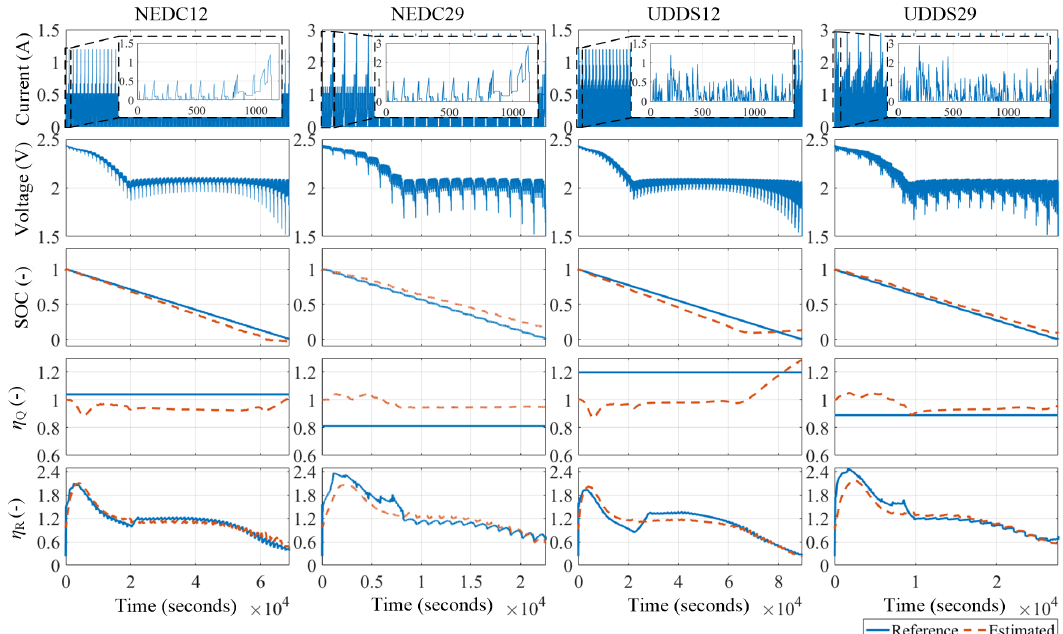
Figure 6. The driving cycle mission profiles and the estimated results for the aged cell. The χ roughly follows the reference. The accuracy of the χ is dependent on the estimated η Q , which varies with the total discharged capacity of the cell under different mission profiles, due to their different current rates and dynamics. The η R is in general followed well and is similar between the different driving cycles.